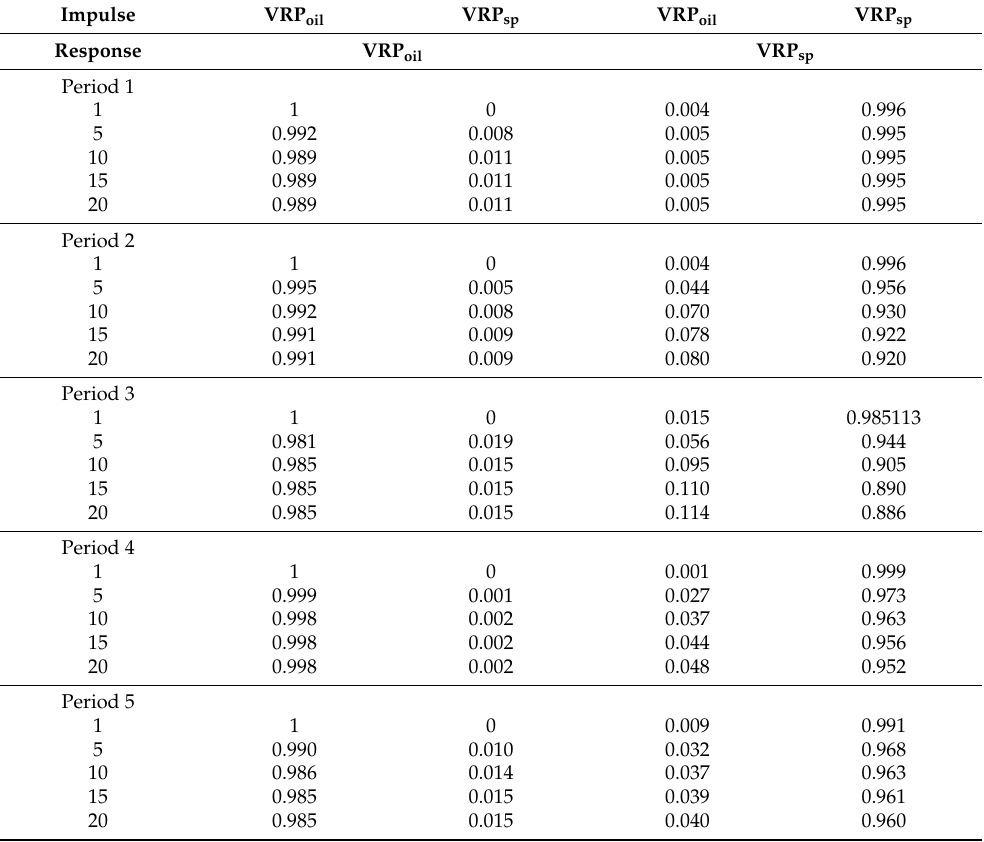
Table 8. Variance decompositions